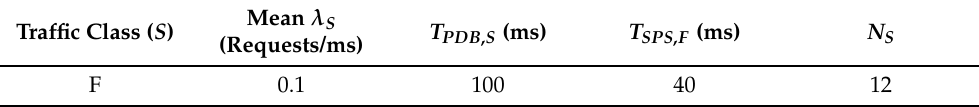
Table 4. Parameters for New Traffic Class